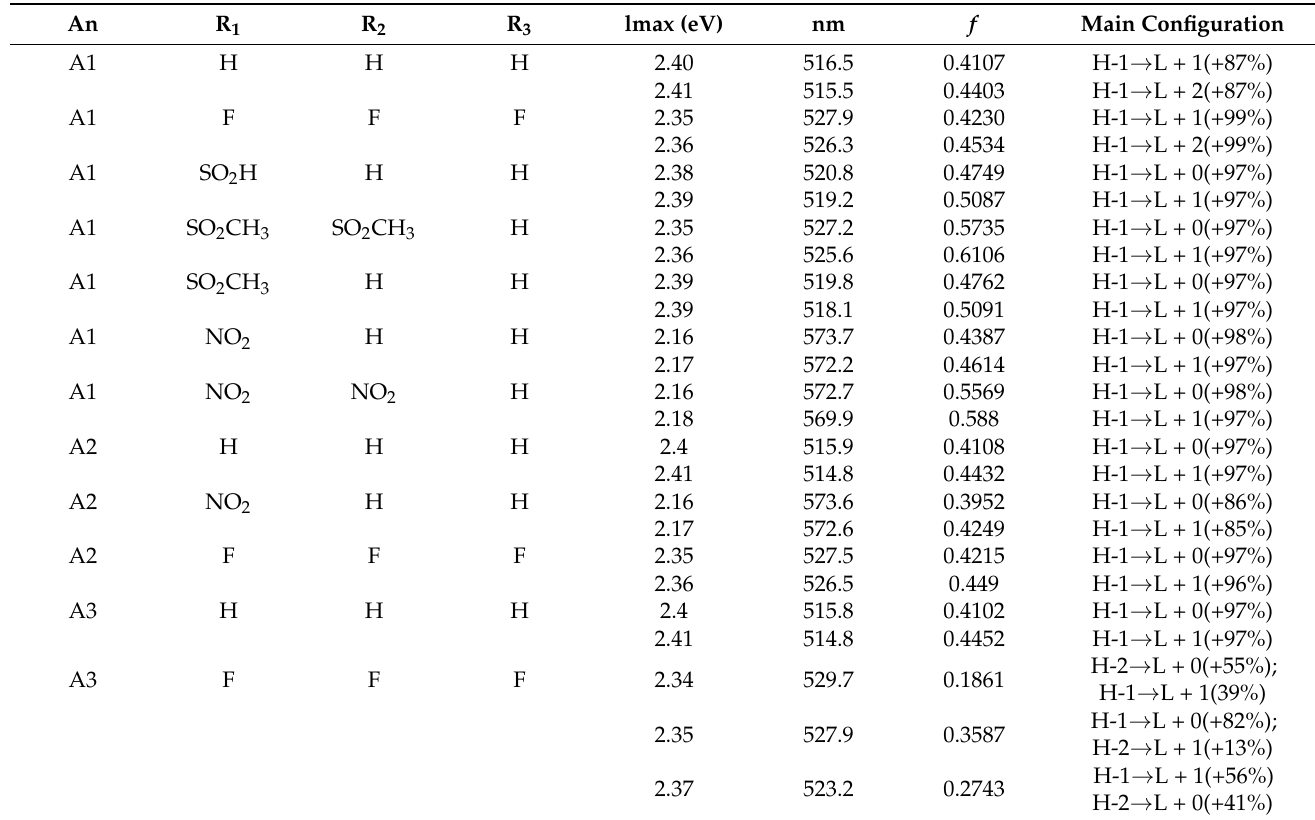
Table 1. Q-band ( λ max ) excitation energies in chloroform, oscillator strengths f and dominant elec- tronic transitions for the SubPcs included in this study a